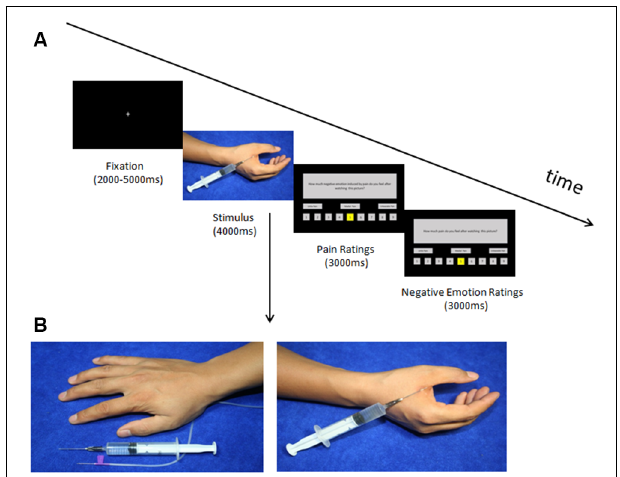
FIGURE 1 | (A) Timeline of the trials in the test phase and (B) two sample pictures. (A) Trial structure of the test phase. A fixation point appeared followed by the picture; after the picture disappeared the participants rated the pain intensity and negative emotion induced by watching the picture (within 3 s each). (B) In the no-pain condition, two needles (injection and intravenous) were placed next to the hands, whereas, in the pain condition, a needle was inserted into the